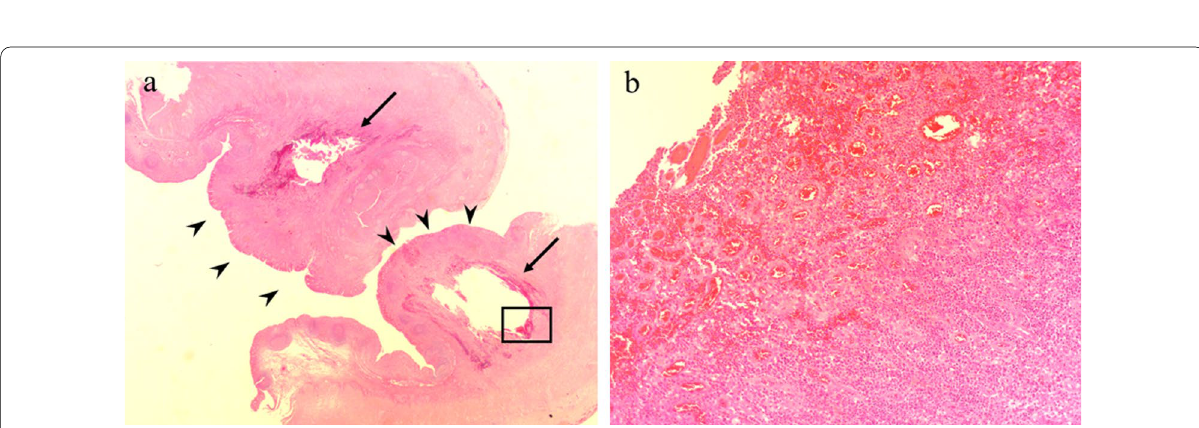
Fig. 4 Histopathological findings. a The white spaces (black arrow) are the positions where the fecalith existed. There was a mucosa (black arrowhead) only above the fecalith. (Hematoxylin–eosin stain, original magnification epithelial cells were observed. Hematoma components and numerous inflammatory cells were observed. (Hematoxylin–eosin stain,